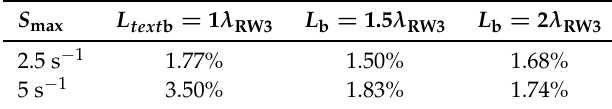
Table A1. Reflection coefficients for different combinations of L b and D max